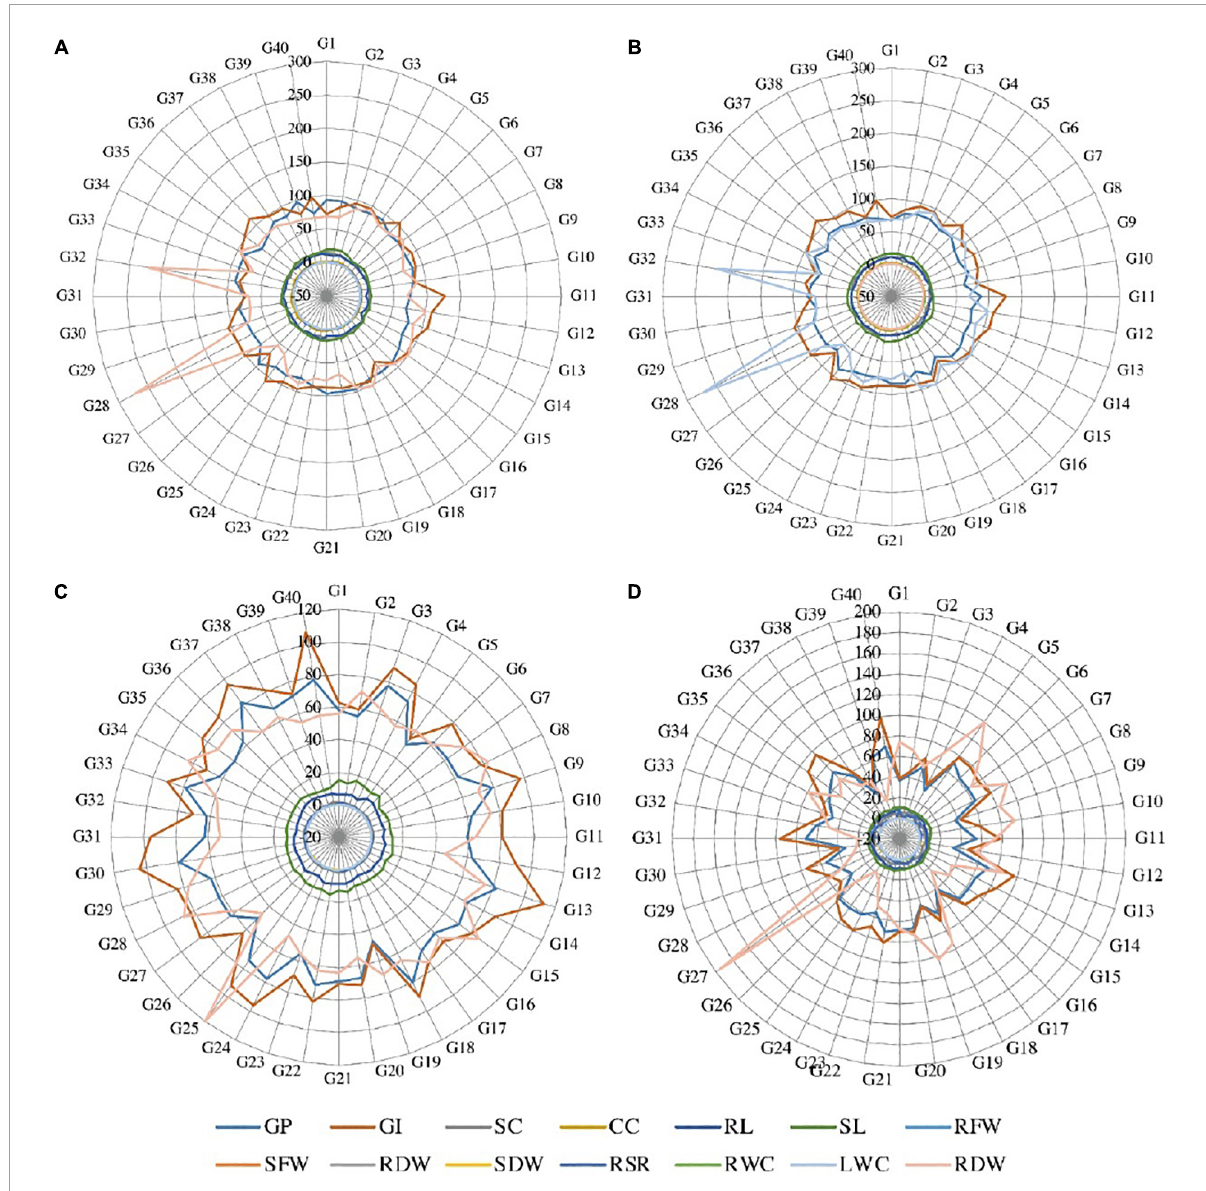
FIGURE1 Radar graph between the studied traits under (A) normal condition, (B) salinity stress at 4 dSm − 1 , (C) salinity stress at 8 dSm − 1 , and (D) salinity stress at 12 dSm − 1 . GP, germination percentage; GI, germination index; SC, stomatal conductance; CC, chlorophyll content; RL, root length; SL, shoot length; RFW, root fresh weight; SFW, shoot fresh weight; RDW, root dry weight; SDW, shoot dry weight; RWC, relative water content; LWC, leaf water content; RSR, root shoot ratio; RDW, relative dry